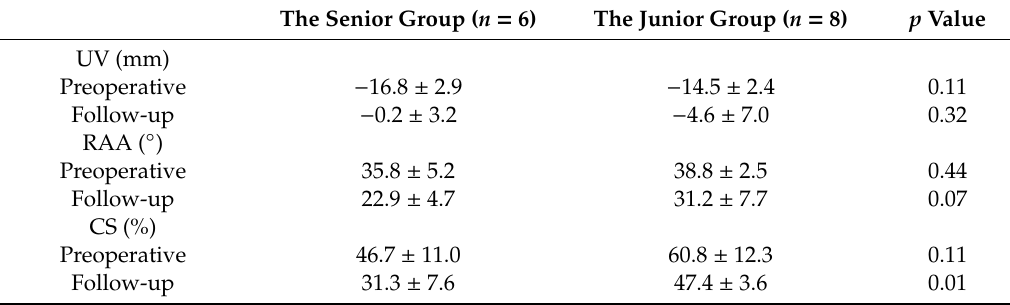
Figure 3. Comparisons between preoperative and follow-up range of motion. ( a ) Supination; ( b ) pronation. * p < 0.05. Table 3. Radiographic